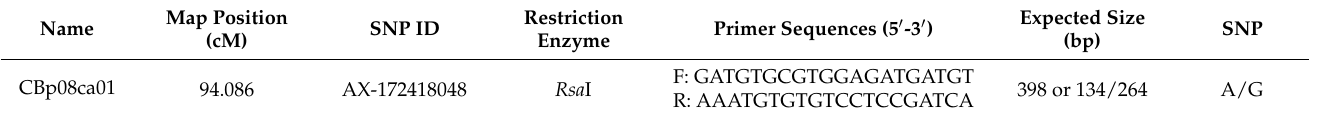
Table 2. Designed candidate CAPS markers associated with russet formation on pear fruit skin.